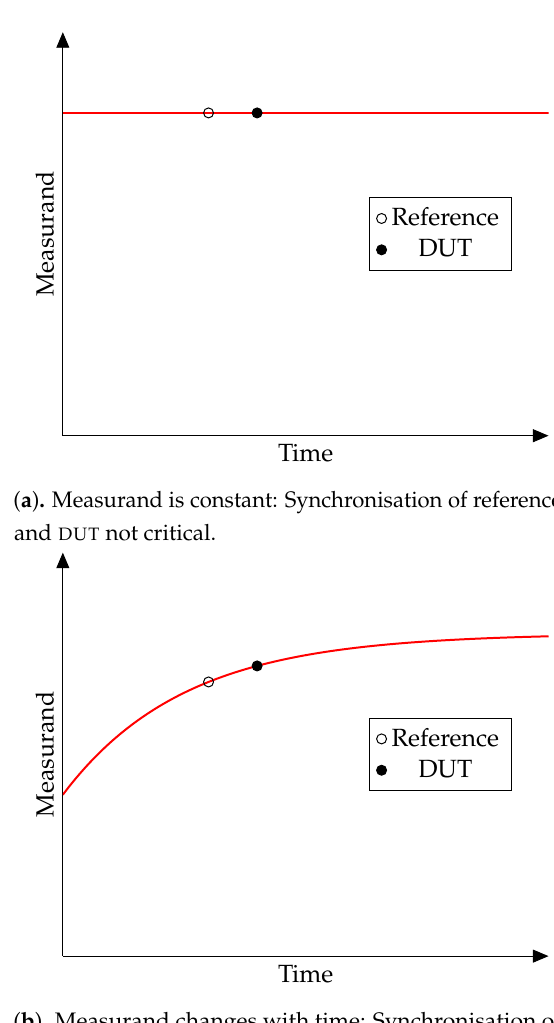
Figure 3. Qualitative illustration: Short-term stability of the measurand and the importance of synchronisation of reference and DUT . The quantitative impact strongly depends on the particular set-up and is very magnitude dependent. It needs to be evaluated for every individual case. While the principle applies to any measurand, the current is particularly liable to time dependency in this application, while the voltage is much more